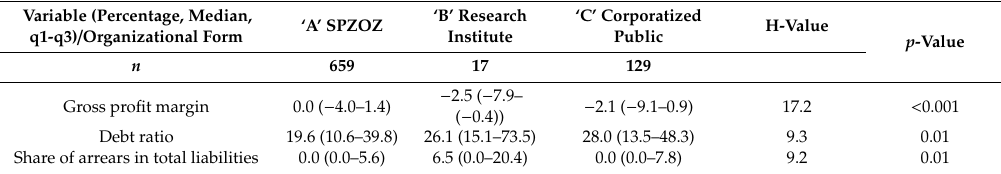
Table 4. Financial indicators per organizational form comparison in